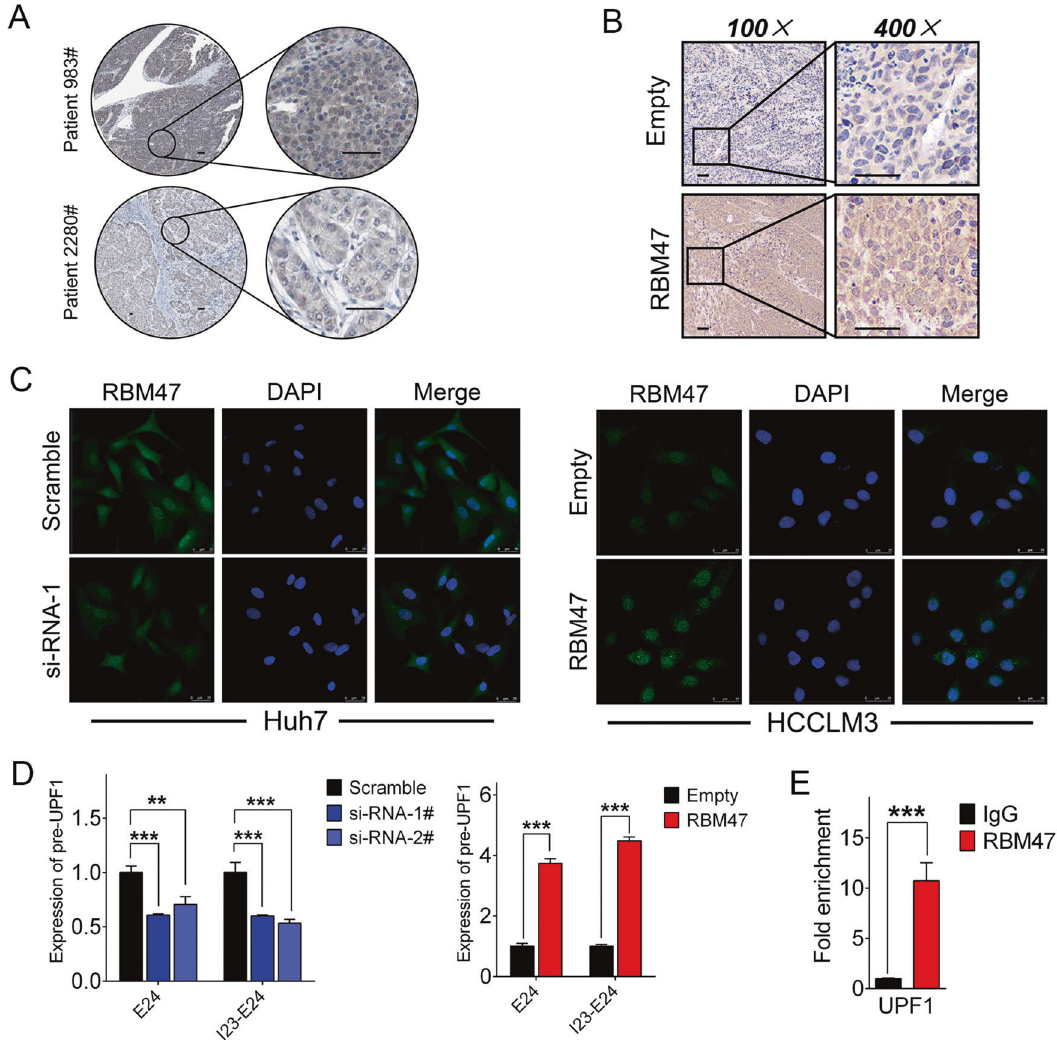
Fig. 7 RBM47 enhanced level of the RBM47 pre-mRNA. The subcellular localization of RBM47 was observed in HCC tissues ( A ) at HPA databank (referred scale bars = 48 μ m), subcutaneously implanted tumors of nude mice ( B ) by IHC (scale bars = 50 μ m), and in hepatoma cells ( C ) by IF after RBM47 silencing or enforced enhancement (scale bars = 25 μ m). D The intranuclear UPF1 pre-mRNA was tested by qRT-PCR in Huh7 cells with RBM47 knockdown and in HCCLM3 cells with RBM47 overexpression. Error bars are SD ( n = 3). E ChIP experiments were performed in HCCLM3 cells to detect the direct binding between RBM47 and the UPF1 promoter, and promoter enrichment was tested by qRT-PCR. Error bars are SD ( n = 3). ** P < 0.01, *** P <